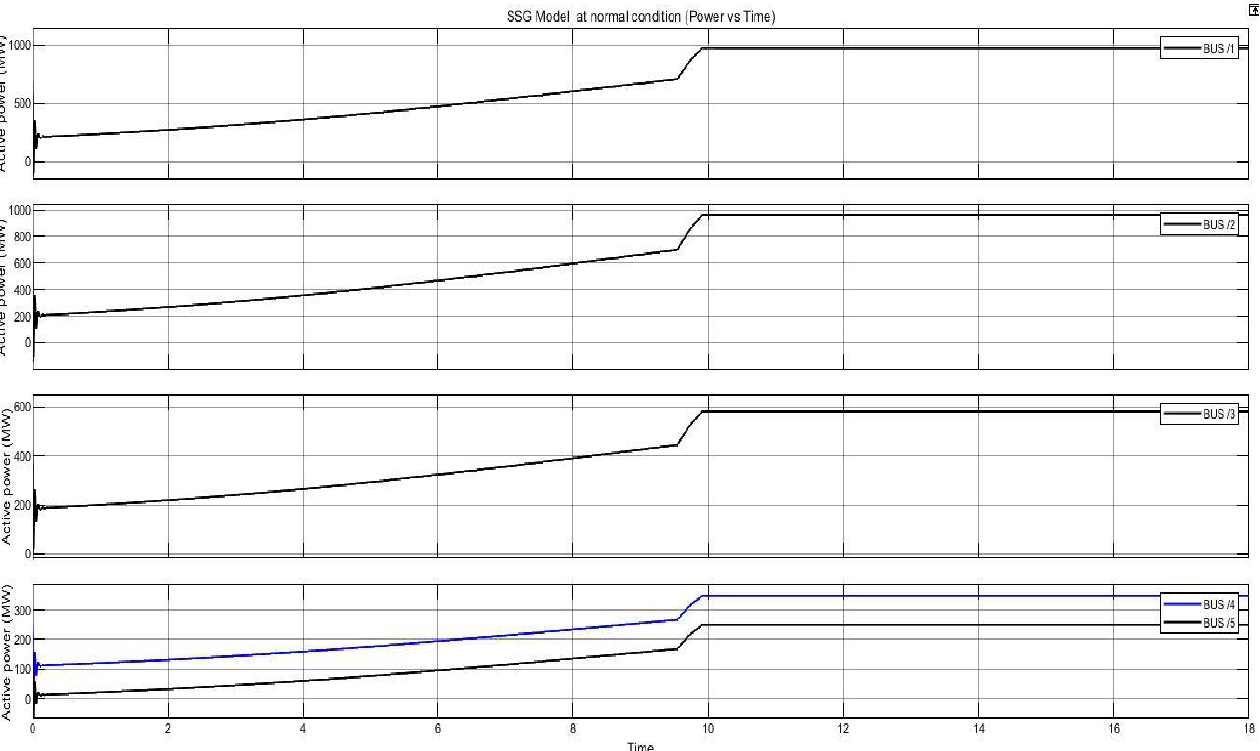
Figure 17. System in normal state, and no fault is introduced (Bus 6 to Bus 10).